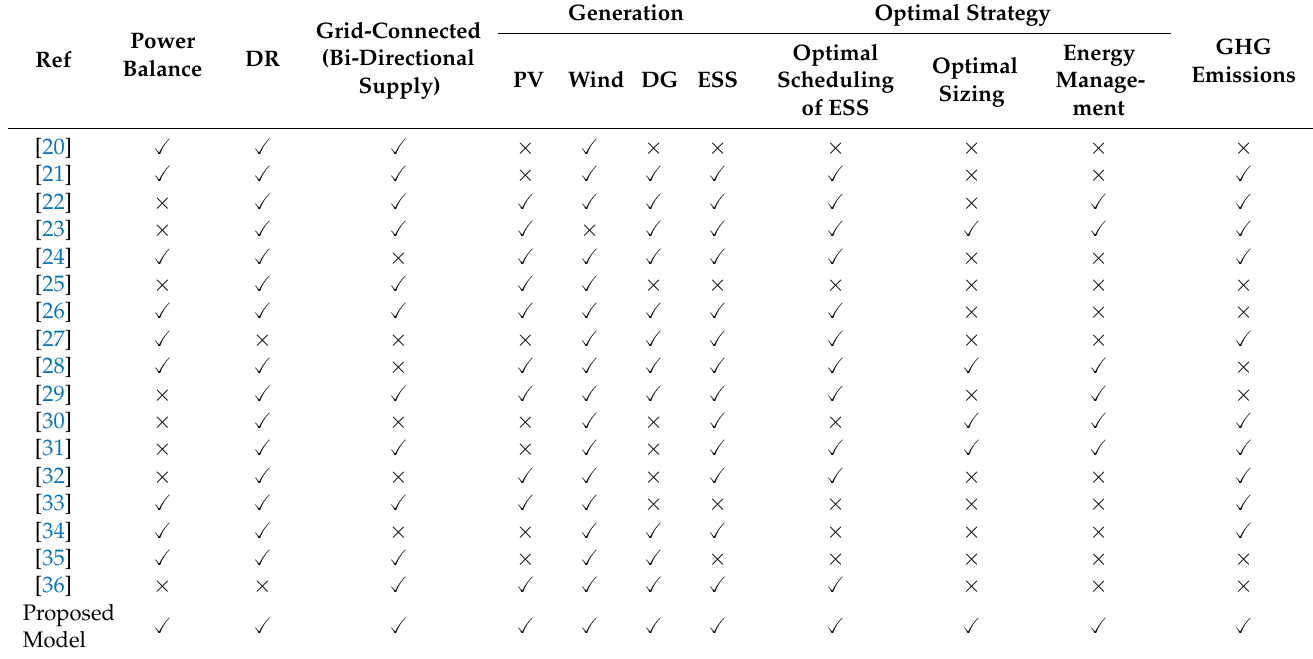
Table 1. Comparison of multiple studies with various